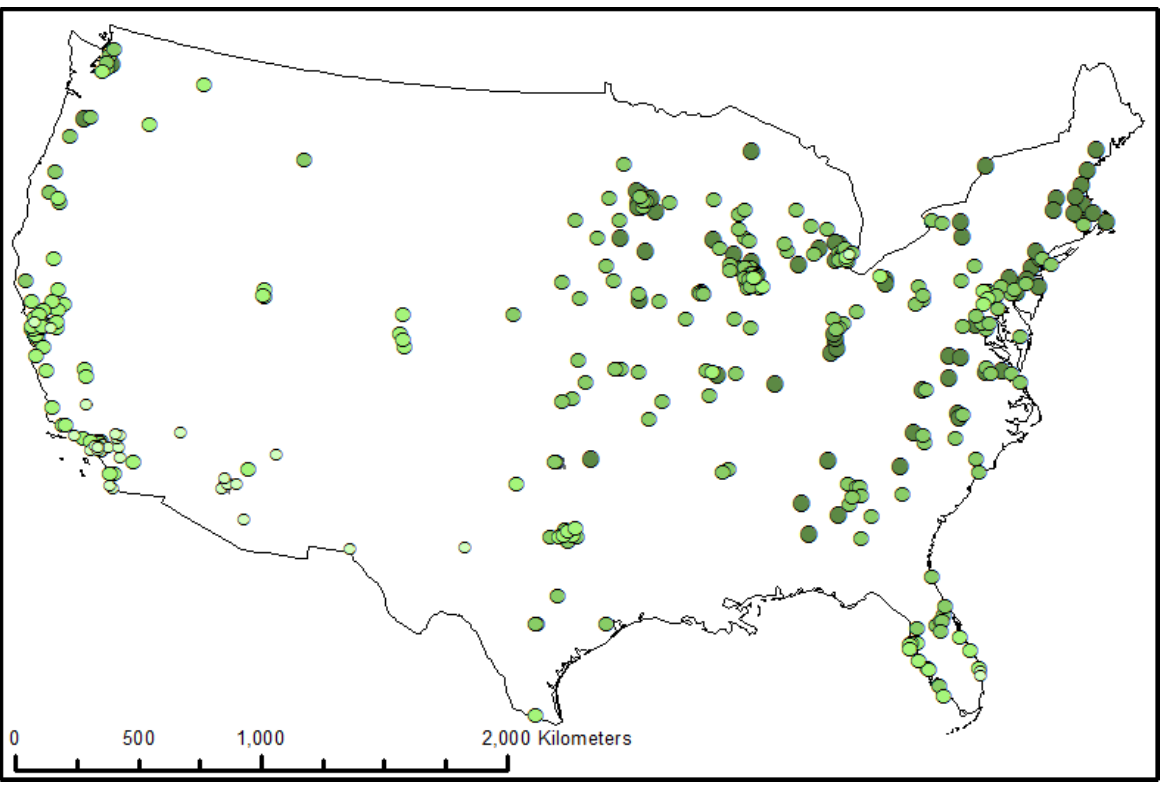
Figure 1. US Cities represented in the International City/County Management Association’s (ICMA) 2010 Local Government Sustainability Survey and the 2009 Economic Development Survey. Darker green indicates higher vegetative